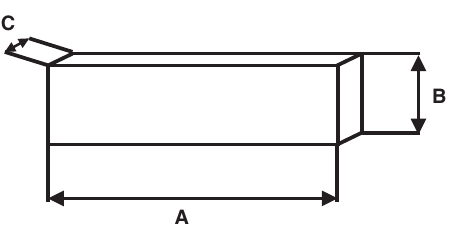
Figure 1: The samples geometry used in high-temperature tests.